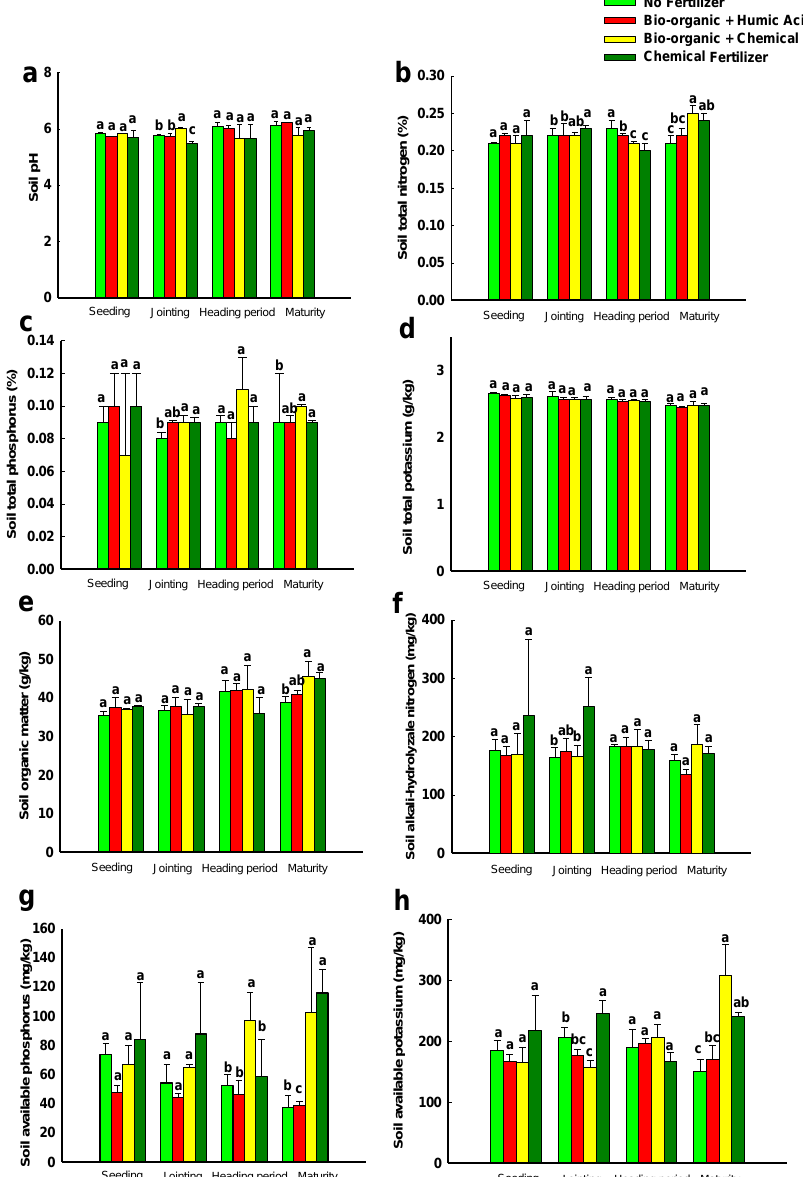
Figure 1. The impact of different fertilization methods on soil chemical properties at four maize growth stages: ( a ) soil pH; ( b ) soil total nitrogen; ( c ) soil total phosphorus; ( d ) soil total potassium; ( e ) soil organic matter; ( f ) soil alkali-hydrolysis nitrogen; ( g ) soil available phosphorus; and ( h ) soil available potassium. Values are mean and standard deviation (± SD, n = 3), different letters indicate significant difference at the 0.05 level.